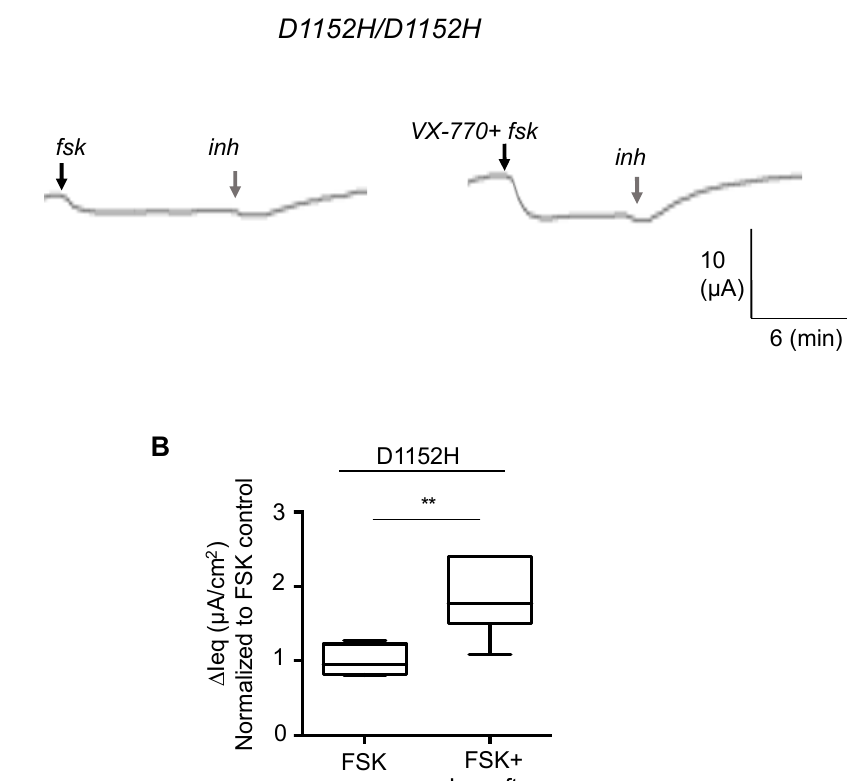
Figure 4. The bicarbonate conductance defect is rescued by ivacaftor. ( A ) Representative current tracings from Ussing chamber studies in Chloride-free bu ff er to study bicarbonate conductance of the CFTR channel in nasal cell cultures from CF patient carrying D1152H / D1152H. ( B ) Bar graph showing the fold increased forskolin (10 µ M) +/ − VX-770 (1 µ M) activated ∆ Ieq compared to forskolin (10 µ M) control ( n = 7 replicates). (** p < 0.01)